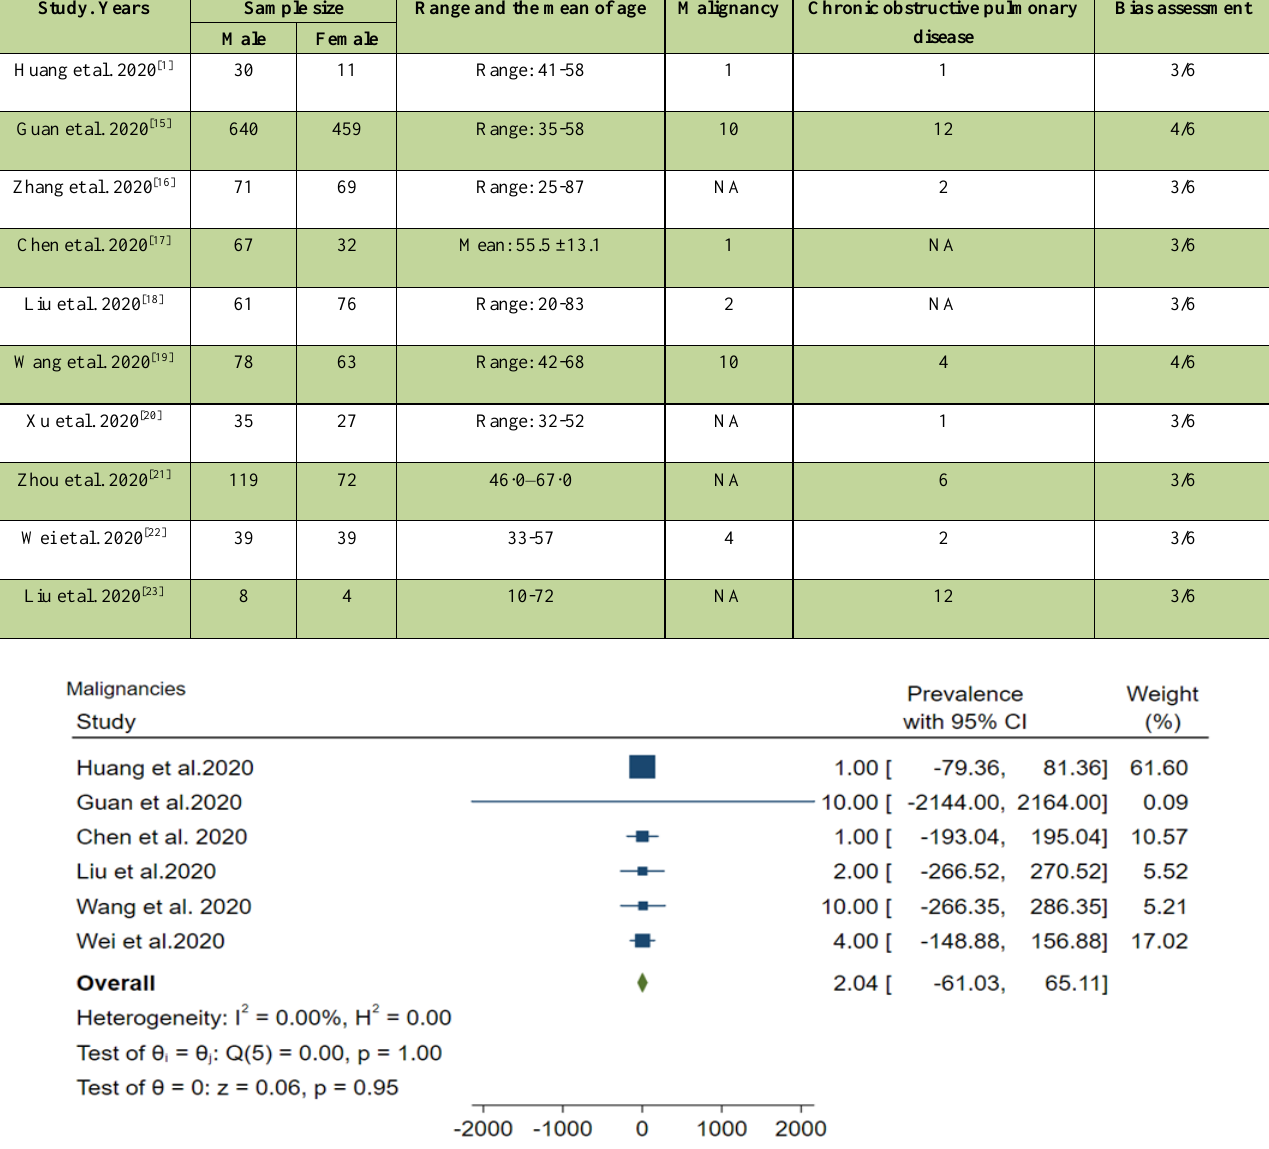
Table 1. Studies included systematic review and meta-analysis.